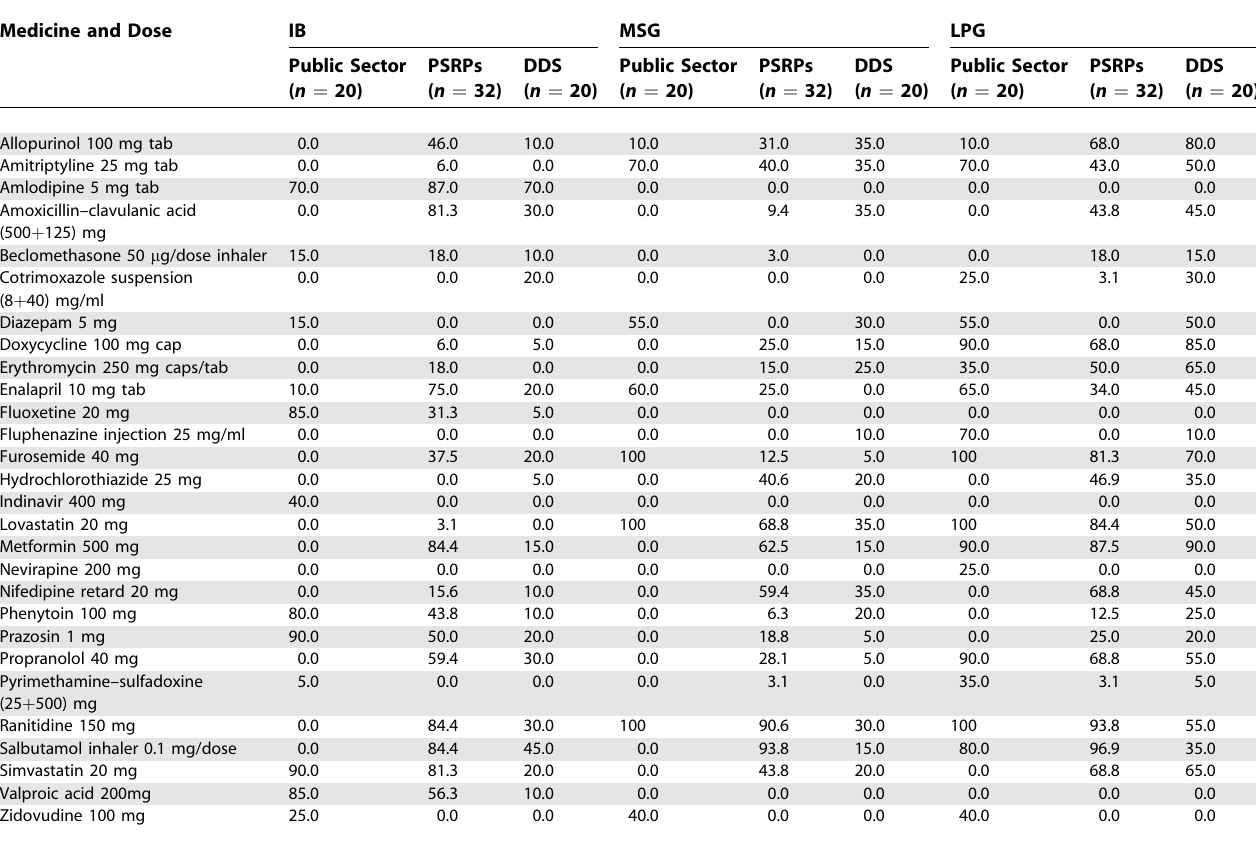
Table 4. Median Percentage Availability of Selected Medicines in the Public Sector, Private Retail Pharmacy Sector, and Dispensing Doctors’ Sector Medicine and